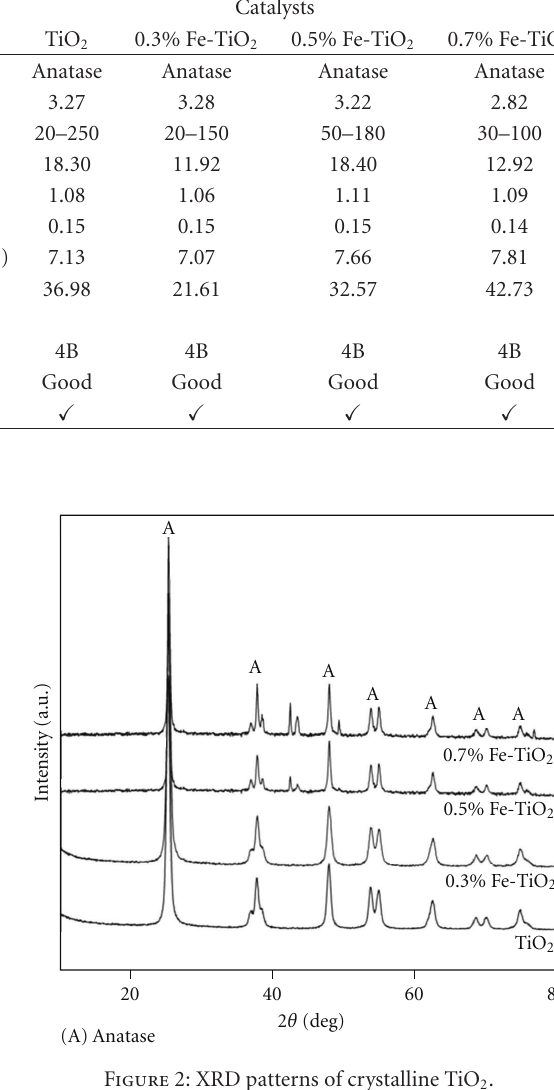
Figure 2: XRD patterns of crystalline TiO 2 .